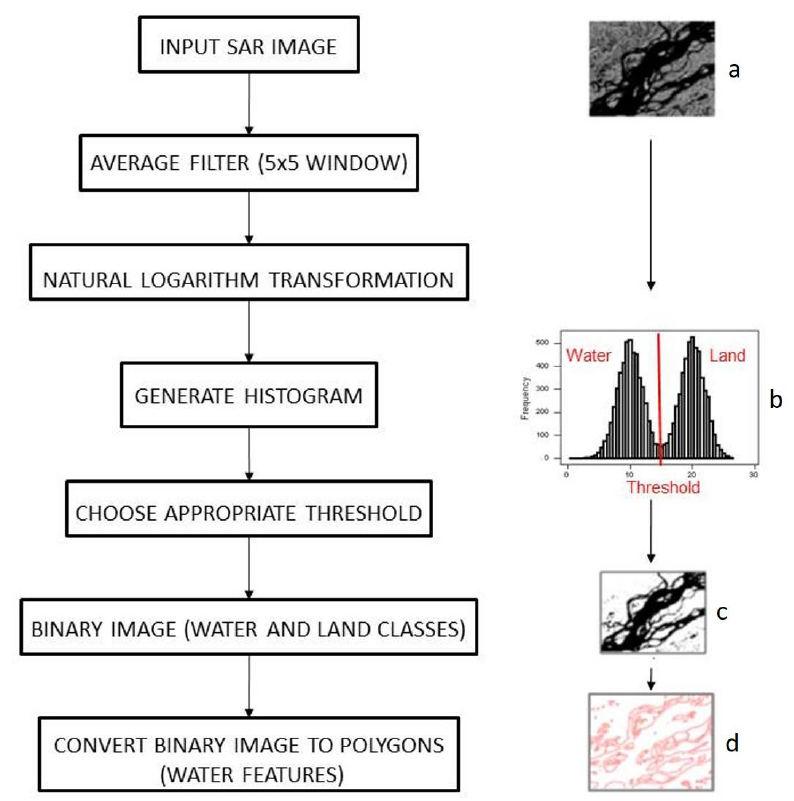
Figure 4. Workflow for extraction of water features: ( a ) SAR image, ( b ) Histogram showing water and land classes, threshold (red line), ( c ) Binary image (Black is water class), ( d ) Polygon boundaries of water features